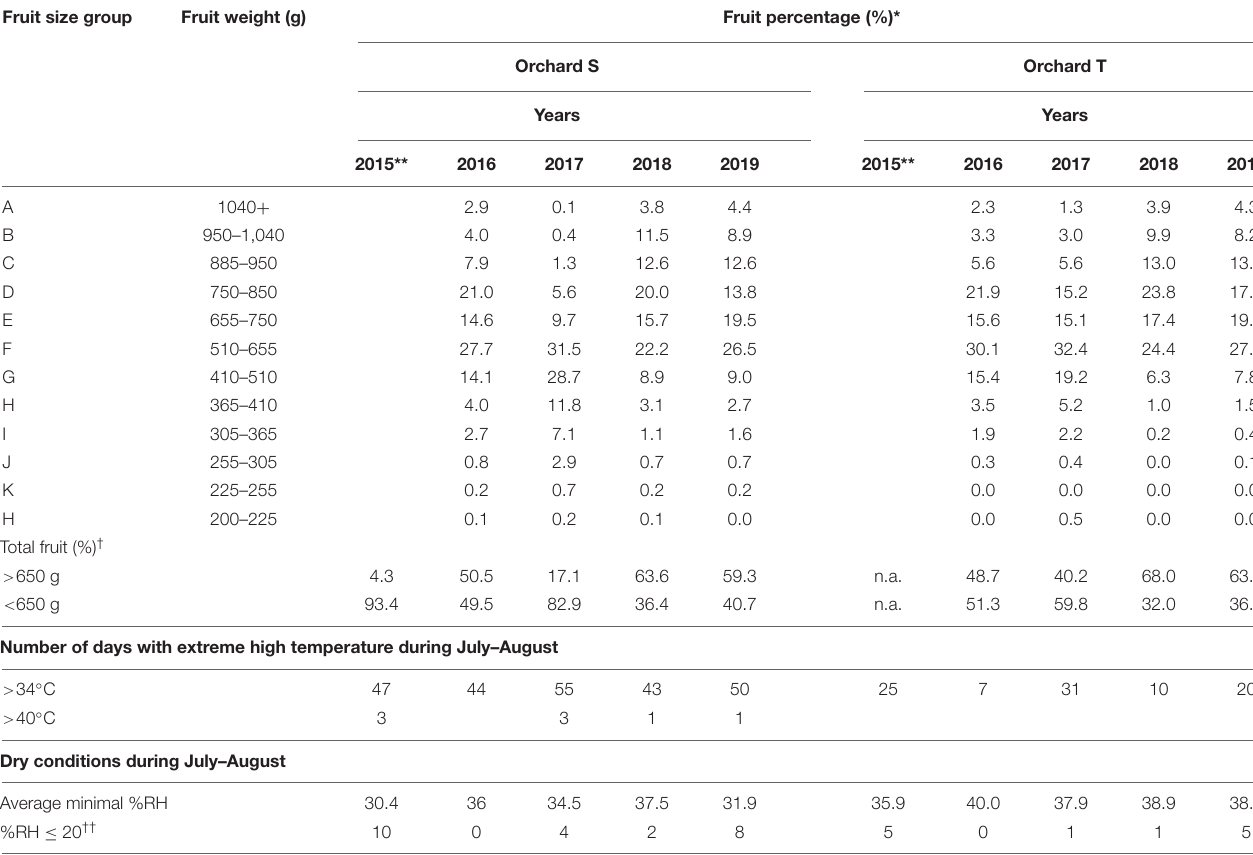
TABLE 1 | Multiyear data of fruit size and climatic conditions. Fruit size group Fruit weight (g) Fruit percentage (%)*